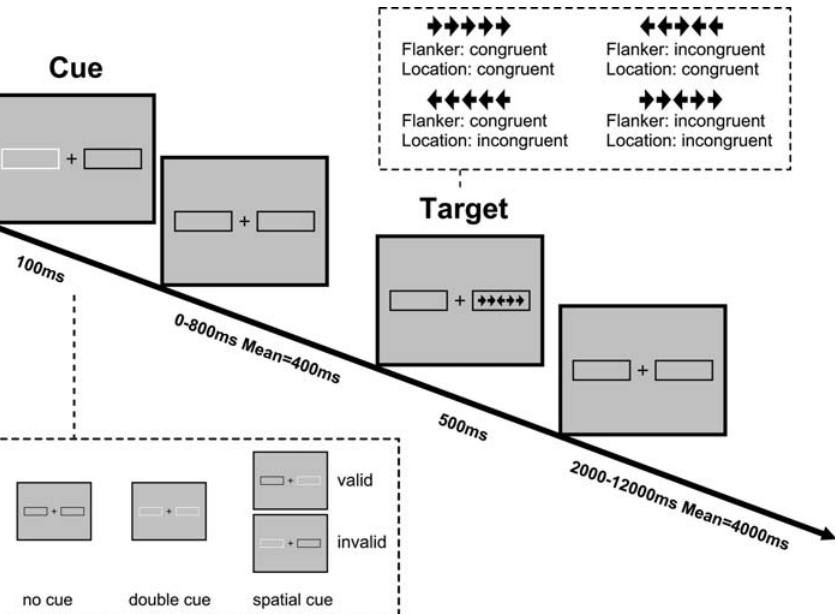
Figure 1. Schematic of the revised Attention Network Test (ANT-R). In each trial, depending on the cue condition (none, double, and valid or invalid cues), a cue box flashes for 100 ms. After a variable duration (0, 400, or 800 ms), the target (the center arrow) and two flanker arrows on the left and right side (congruent or incongruent flankers) are presented for 500 ms. The participant makes a response to the target’s direction. The post- target fixation period varies between 2000 to 12000